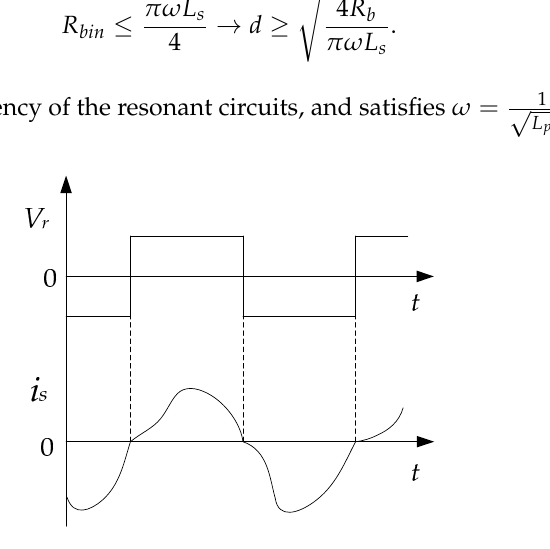
Figure 2. Continuous current condition waveforms of the system.